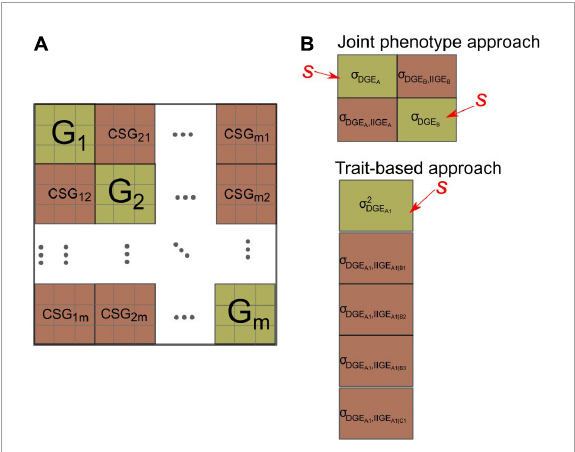
FIGURE3 (A) Structure of the compounded community-level G-matrix that would be required to be able to predict genetic changes in species traits in a community of m species potentially under selection for their DGE. It includes both G-matrices (in green) on the diagonal (G 1 , G 2 ... G m ) for each species (equivalent to the one in eq. 10a) and reciprocal cross species G-matrices (CSG) (in dark red), representing genetic covariances among species traits, i.e., covariances between DGE and IIGE for each pair of traits belonging to different species. The figure depicts three measured traits per species. See main text for a discussion on the limits of the concept of the compounded community-level G-matrix in relation to DGE and IIGE. (B) Same representations for specific examples of the CSG-matrices that would be required to predict the response to artificial selection at the community level [with “s” indicating the trait(s) under selection]. Top: The particular case of the joint phenotype approach with selection on the DGE of each species. The prediction of the community variable c then requires the variance of DGE for each species and the covariances between DGE and IIGE affecting the other species. Bottom: Example of a trait-based approach with selection only applied to trait A 1 of species A , and predictions focused on three traits of species B ( B 1 – B 3 ) one trait of species C ( C 1 ), all being potential components of the community-level target c (refer to main text for details). In cases where the magnitude of the genetic covariance between DGE and IIGE is non-null, the evolution of this first trait is expected to affect the magnitude of IIGE on other species’ traits, hence the mean value of other species traits. The notation σ DGE , A 1 , IIGGE A 1 | B 1 for instance, denotes the covariance between the DGE of species A associated with trait A 1 vs. its IIGE affecting the trait B 1 of species B